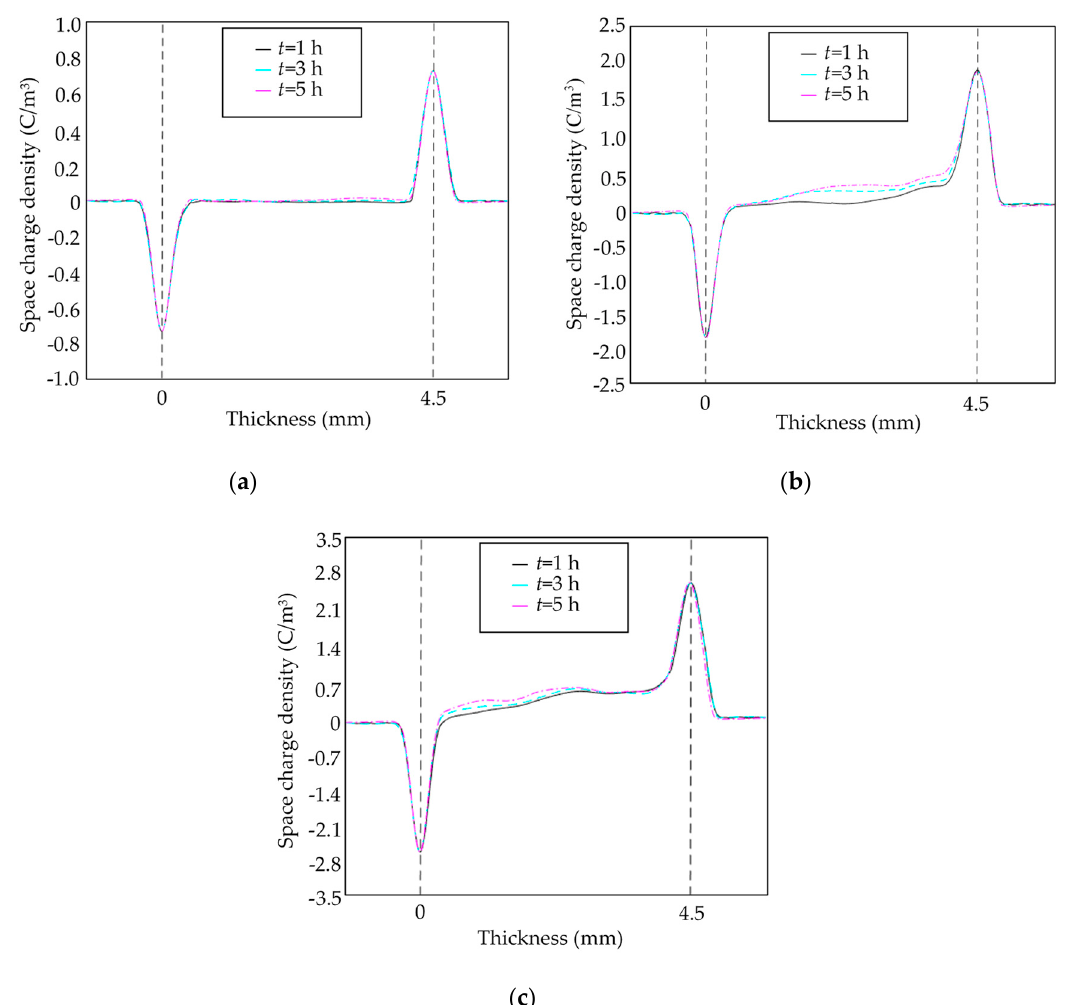
Figure 4. Space charge distribution under the applied DC voltage of 67.5 kV: ( a ) at room temperature; ( b ) insulation with a temperature difference of 15 °C; ( c ) insulation with a temperature difference of 30 °C.